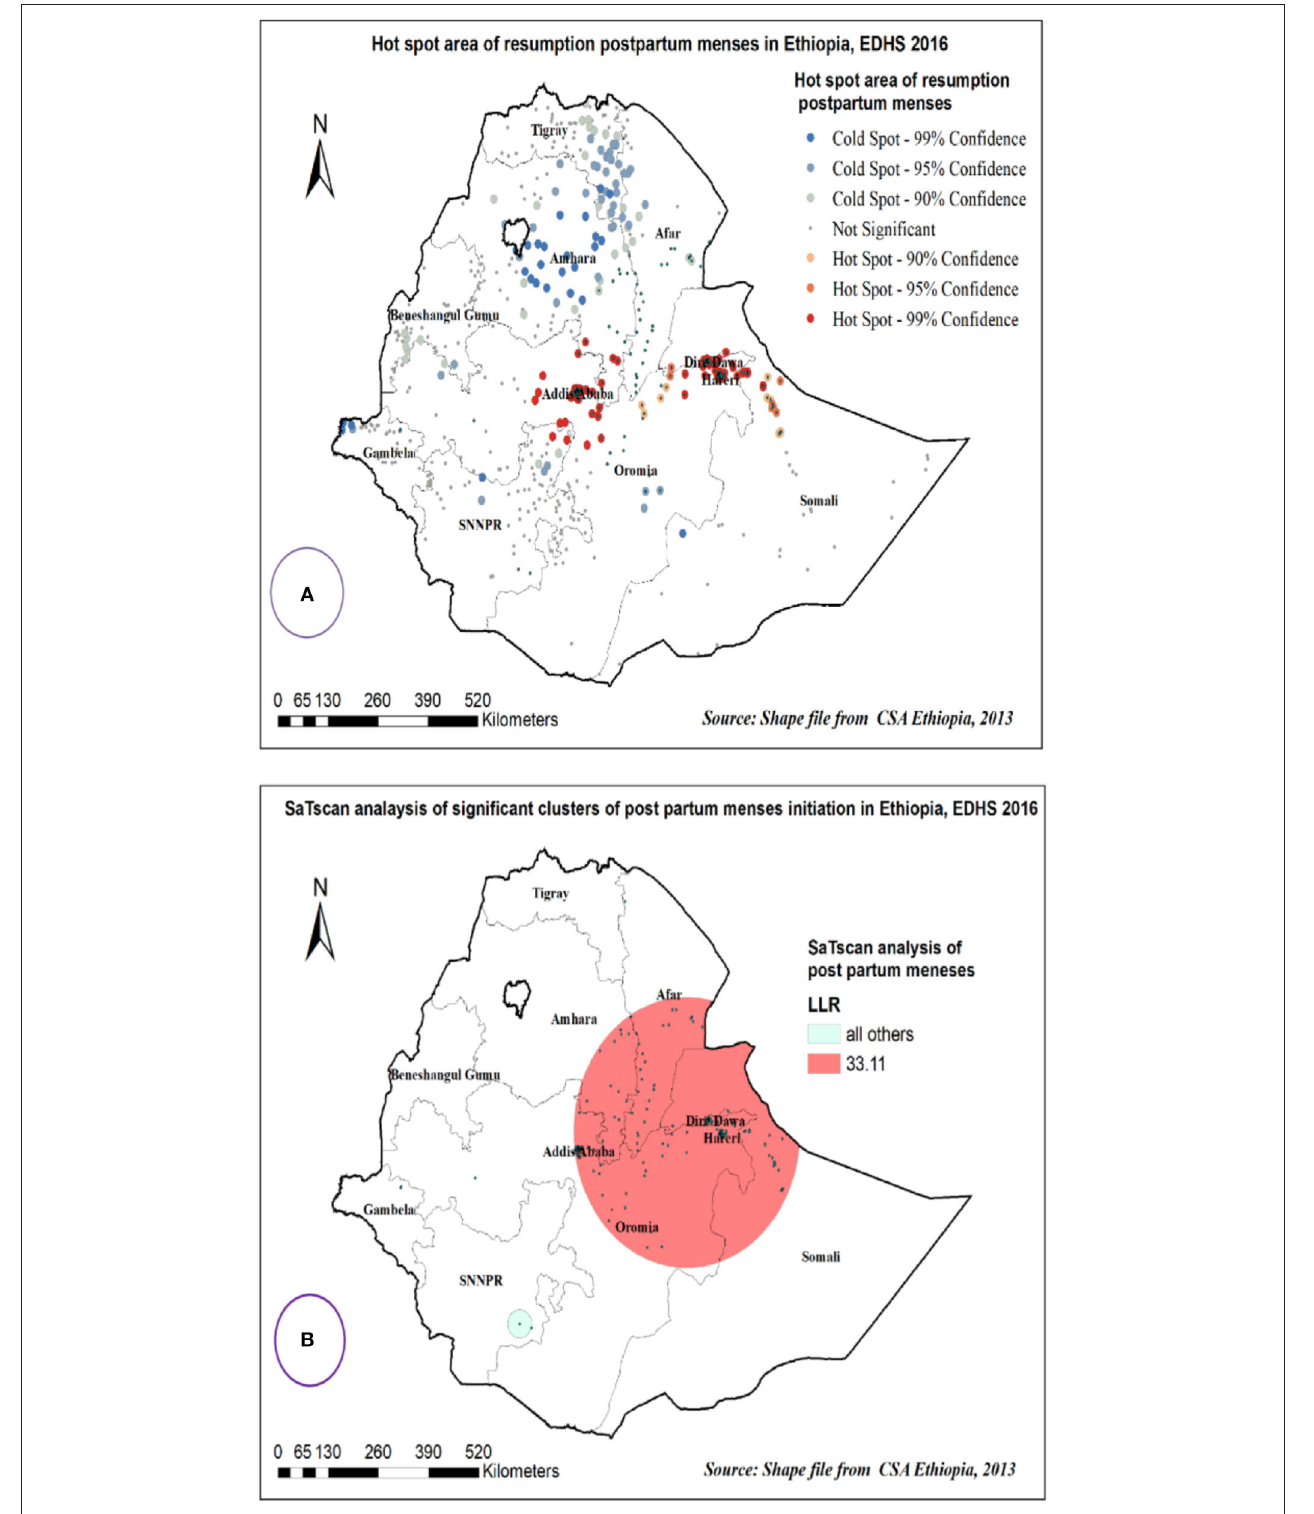
FIGURE 4 | Hot spot area (A) and spatial windows (B) of postpartum menses resumption in Ethiopia, EDHS 2016.